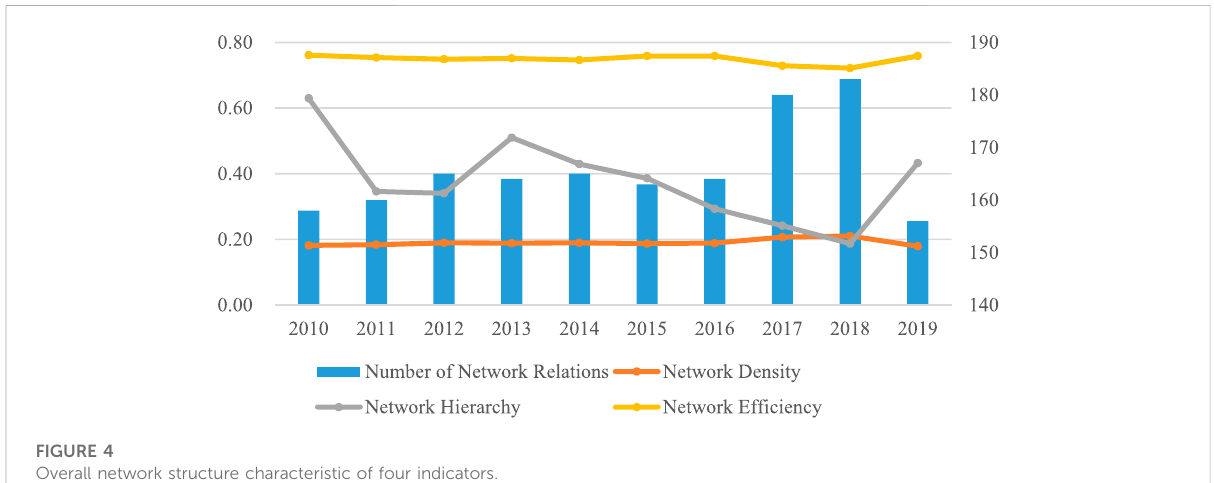
FIGURE 4 Overall network structure characteristic of four